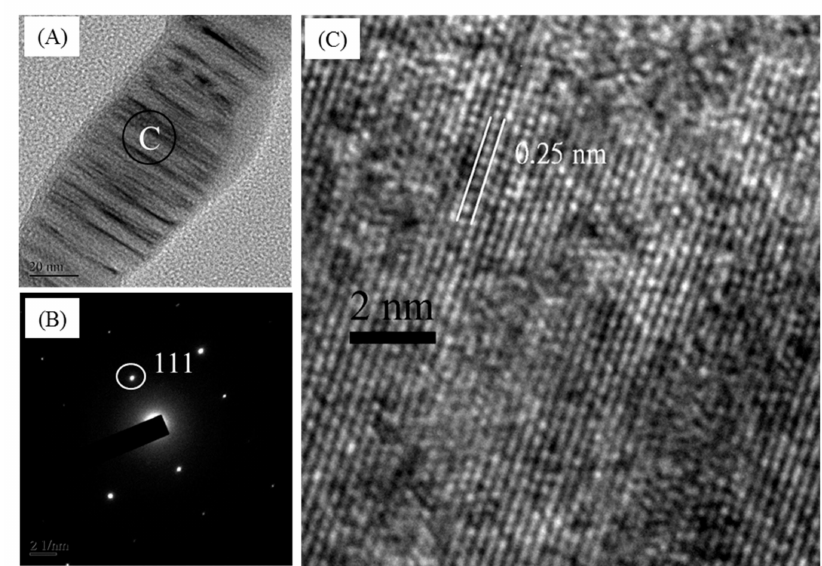
Figure 10. TEM image of a single β -SiC nanowire of sintered BSiC prepared using five repeated cycles of sol–gel impregnation ( A ), SAED pattern ( B ), and HRTEM image ( C ) observed for the β -SiC